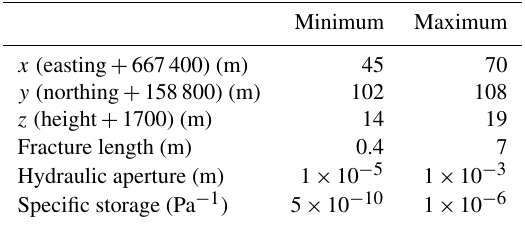
Table 2. Uniform prior distributions defined by a minimum and maximum possible